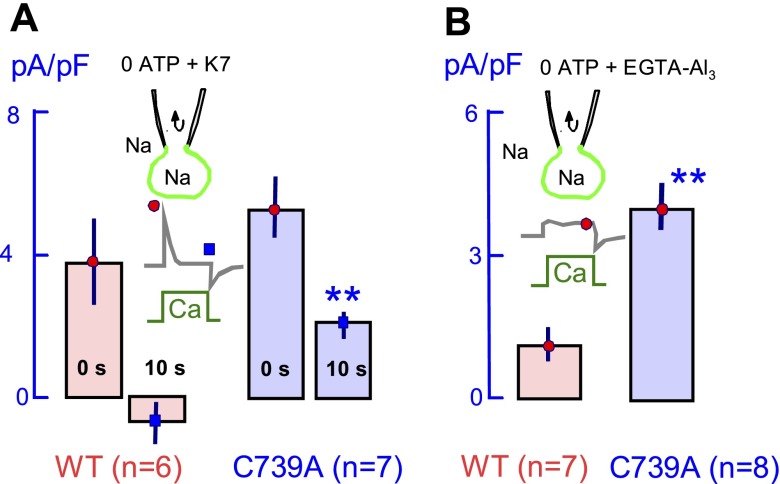
Effect of palmitoylation on NCX1 inactivation by masking anionic phospholipid head groups. Stably transfected FT-293 cells expressing WT and C739A NCX1 were voltage clamped in the whole-cell mode using ATP-free, highly Ca-buffered cytoplasmic solutions (10 mM EGTA with 1 mM Ca). A) Using a cytoplasmic solution containing 20 µM heptalysine (K7) to bind head groups of anionic phospholipids, outward exchange currents were activated by stepping extracellular Ca from 0 to 4 mM in cells expressing WT (left) and C739A exchangers (right). Current magnitudes are given for peak currents and current remaining after 10 s. Residual currents are highly significantly increased in cells expressing C739A compared with WT exchangers. B) Using a cytoplasmic solution containing 0.15 mM Al3+ (in the presence of 10 mM EGTA) to bind PIP2 head groups, outward exchange currents were strongly suppressed in cells expressing WT exchangers (left) but remained robust in cells expressing C739A exchangers (right). **P < 0.01.